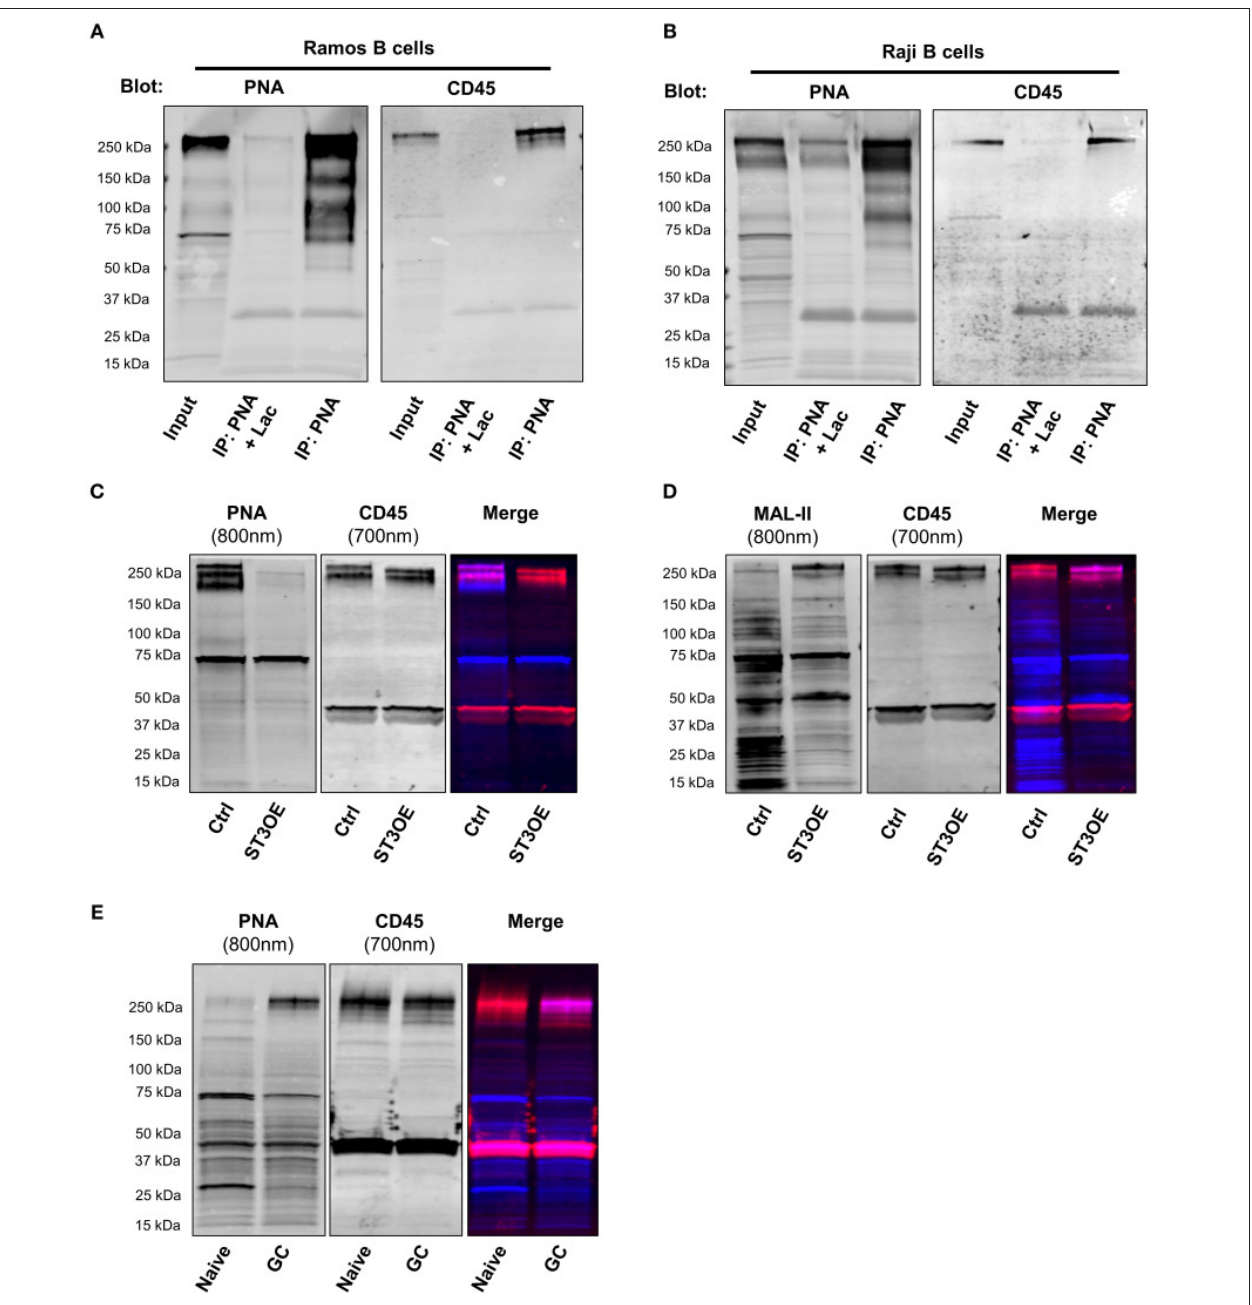
FIGURE 3 | CD45 is a major glycoprotein bearing PNA-reactive O-glycans on B cells. (A) Immunoprecipitation (IP) with PNA-agarose beads from lysates of a GC-derived Burkitt lymphoma B cell line (Ramos), followed by SDS-PAGE and immunoblot with either PNA ( left ) or CD45 antibody ( right ). As a negative control, IP was also performed in the presence of a sugar inhibitor, lactose (Lac; middle lane). (B) IP and immunoblot of PNA-binding proteins of lysates from a second GC-derived Burkitt lymphoma B cell line (Raji), as in (A) . (C) Western blot analysis of PNA binding to Ramos vector control and ST3Gal1OE lysates ( left; 800nm fluorescence channel ) followed by immunoblot with CD45 antibody ( middle, 700nm fluorescence channel). Right, merged. (D) Western blot analysis of staining of Ramos vector control and ST3Gal1OE lysates with MAL-II lectin ( left; 800nm fluorescence channel ) followed by CD45 antibody ( middle, 700nm fluorescence channel). Right, merged. (E) Immunoblot of lysates from magnetically-enriched naïve and GC B cells with PNA ( left; 800nm fluorescence channel ) followed by CD45 antibody ( middle, 700nm fluorescence channel). Right, merged. Data from (A,B) are from one experiment each showing similar results using three different B cell lines (Ramos, Raji, and SUDHL4; see also Supplementary Figure 2 ). Data in (C–E) are representative of three independent experiments with distinct cell aliquots or tonsil specimens. Ctrl, vector control; ST3OE, ST3Gal1OE.